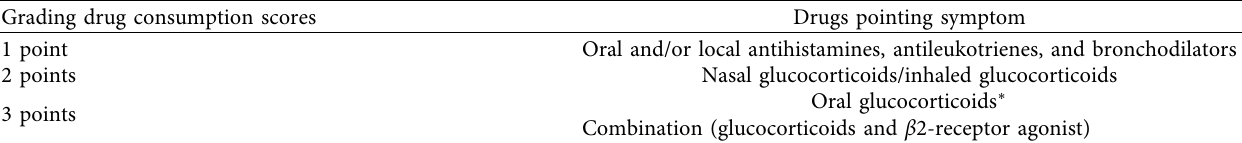
Table 3: Symptomatic drug rating scale.